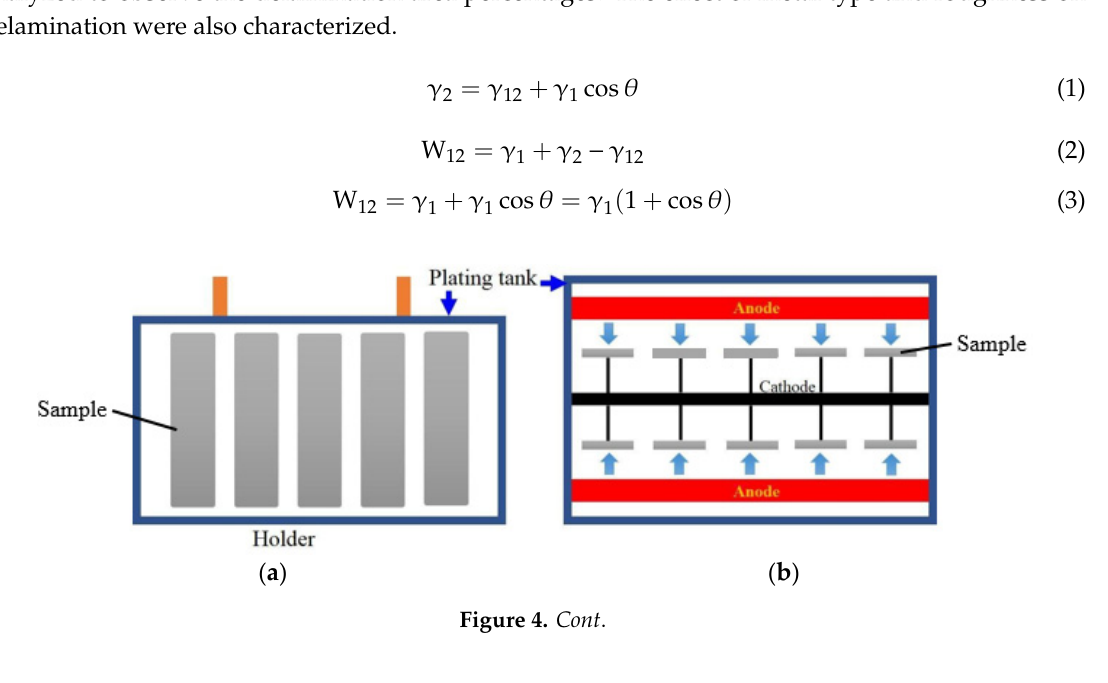
Figure 3. Illustration of contact angle.